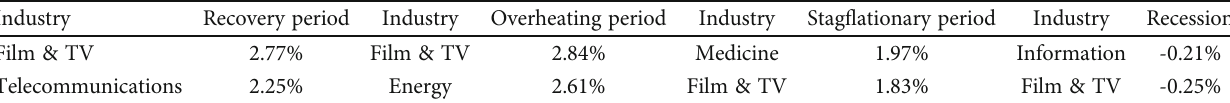
Table 10: Top 2 industry returns at di ff erent stages.